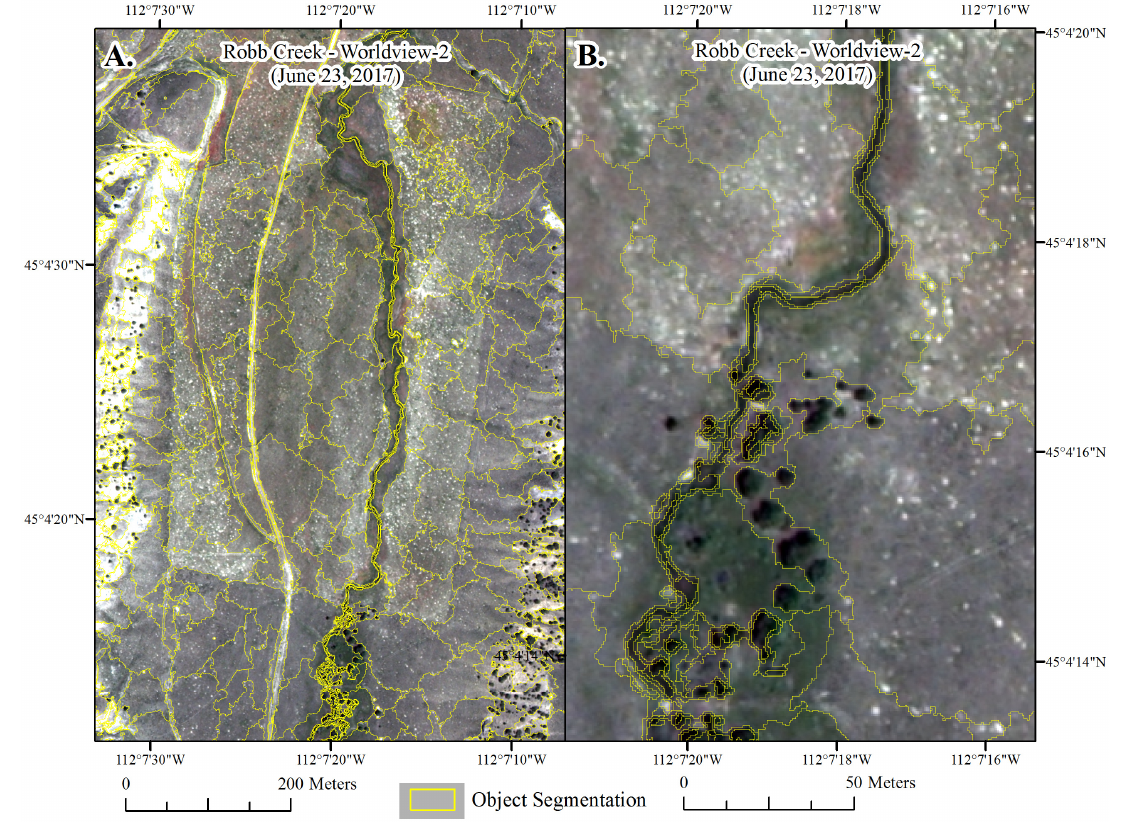
Figure 4. Examples from Robb Creek, Montana, of segmenting an image into objects of interest. Segmentation approaches that focus on detecting edges as well as iterative segmentation at different scales can allow objects to vary in size from large, upland objects ( A ) to narrow, small objects that follow the stream ( B ); DigitalGlobe Copyright 2017.